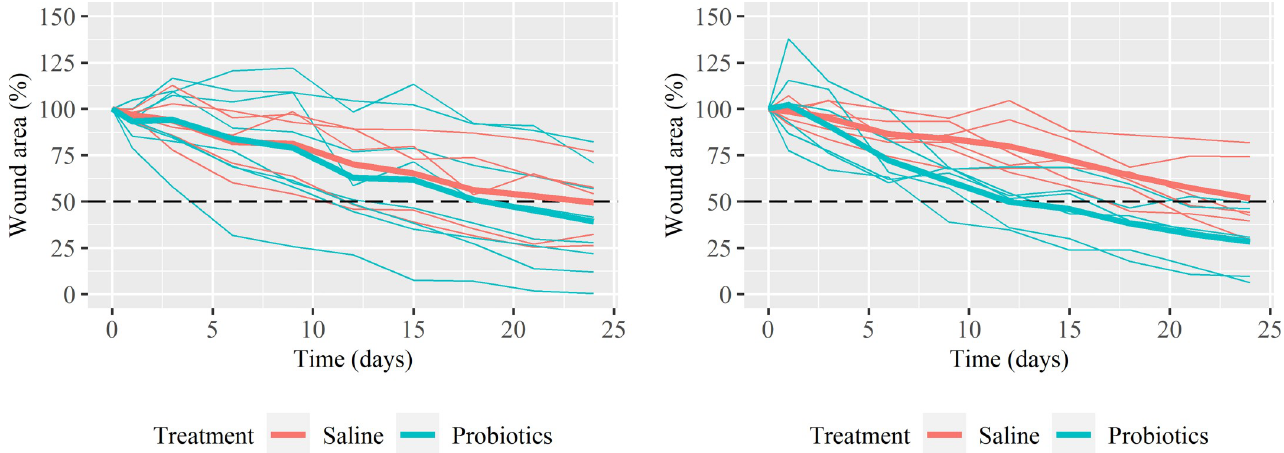
Fig 2. The relative wound area of the wounds as a function of time. Fig 2A represents wounds with Incomplete Granulation Bed (ICGB) and Fig 2B for Complete Granulation Bed (CGB). The thin lines represent the individual wounds and the bold lines represent the mean relative wound area per treatment. The dashed line (- -) indicates the level of 50% wound repair. Missing data are estimated by the mean of the previous and following measurement within horse.